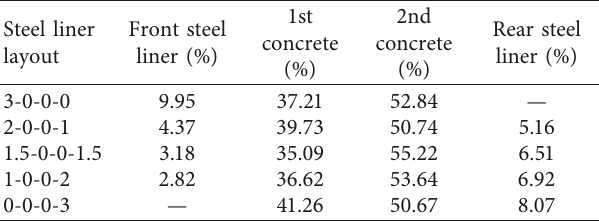
Table 8: Contribution ratio of antiperforation performance with each part of segmented